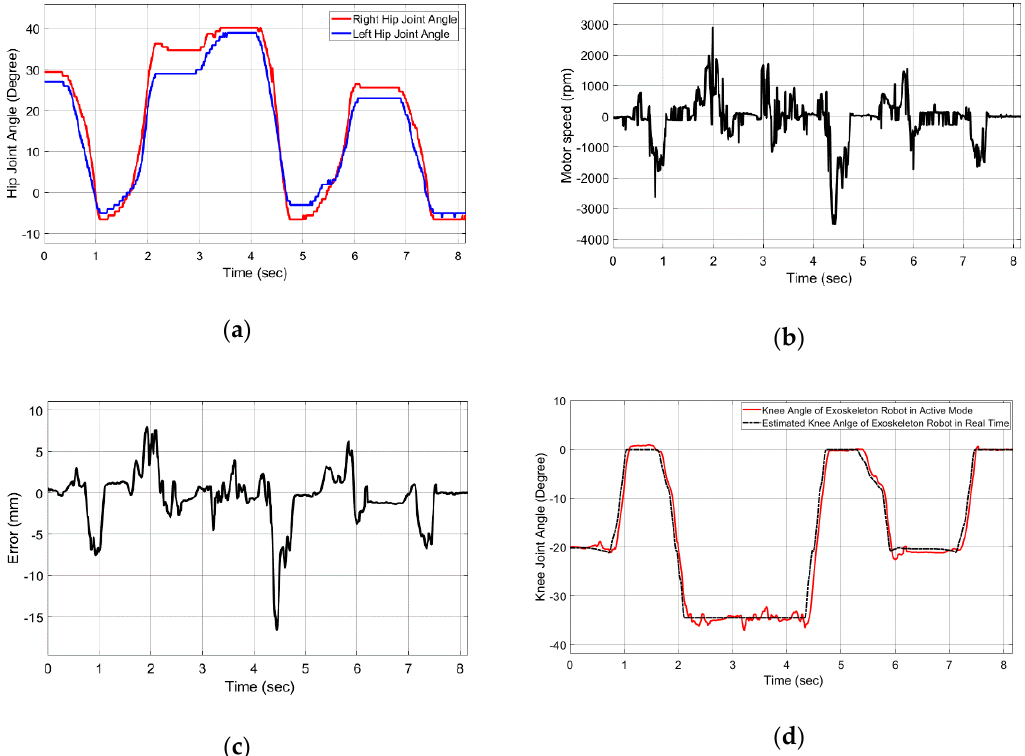
Figure 12. The sit-to-stand movement experiment: ( a ) the change in the hip joint angles, ( b ) the motor speed, ( c ) tracking error, and ( d ) a comparison of the actual and the estimated knee joint angles of the exoskeleton robot.